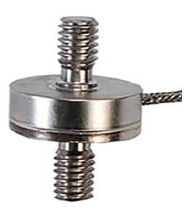
Figure 3. Omega LC201-25 load cell.